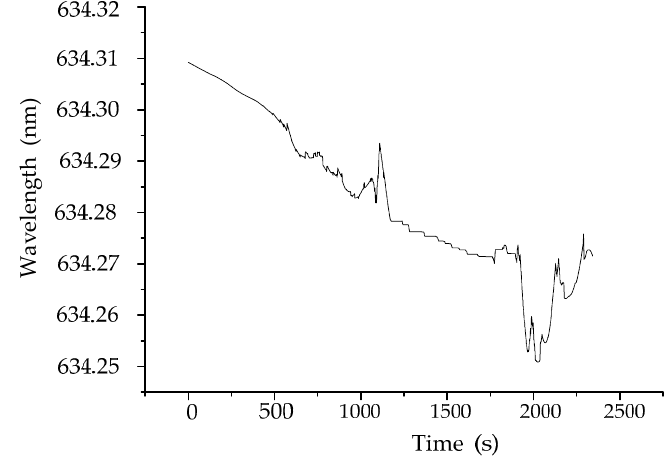
Figure 11. The semiconductor laser wavelength stability monitoring.